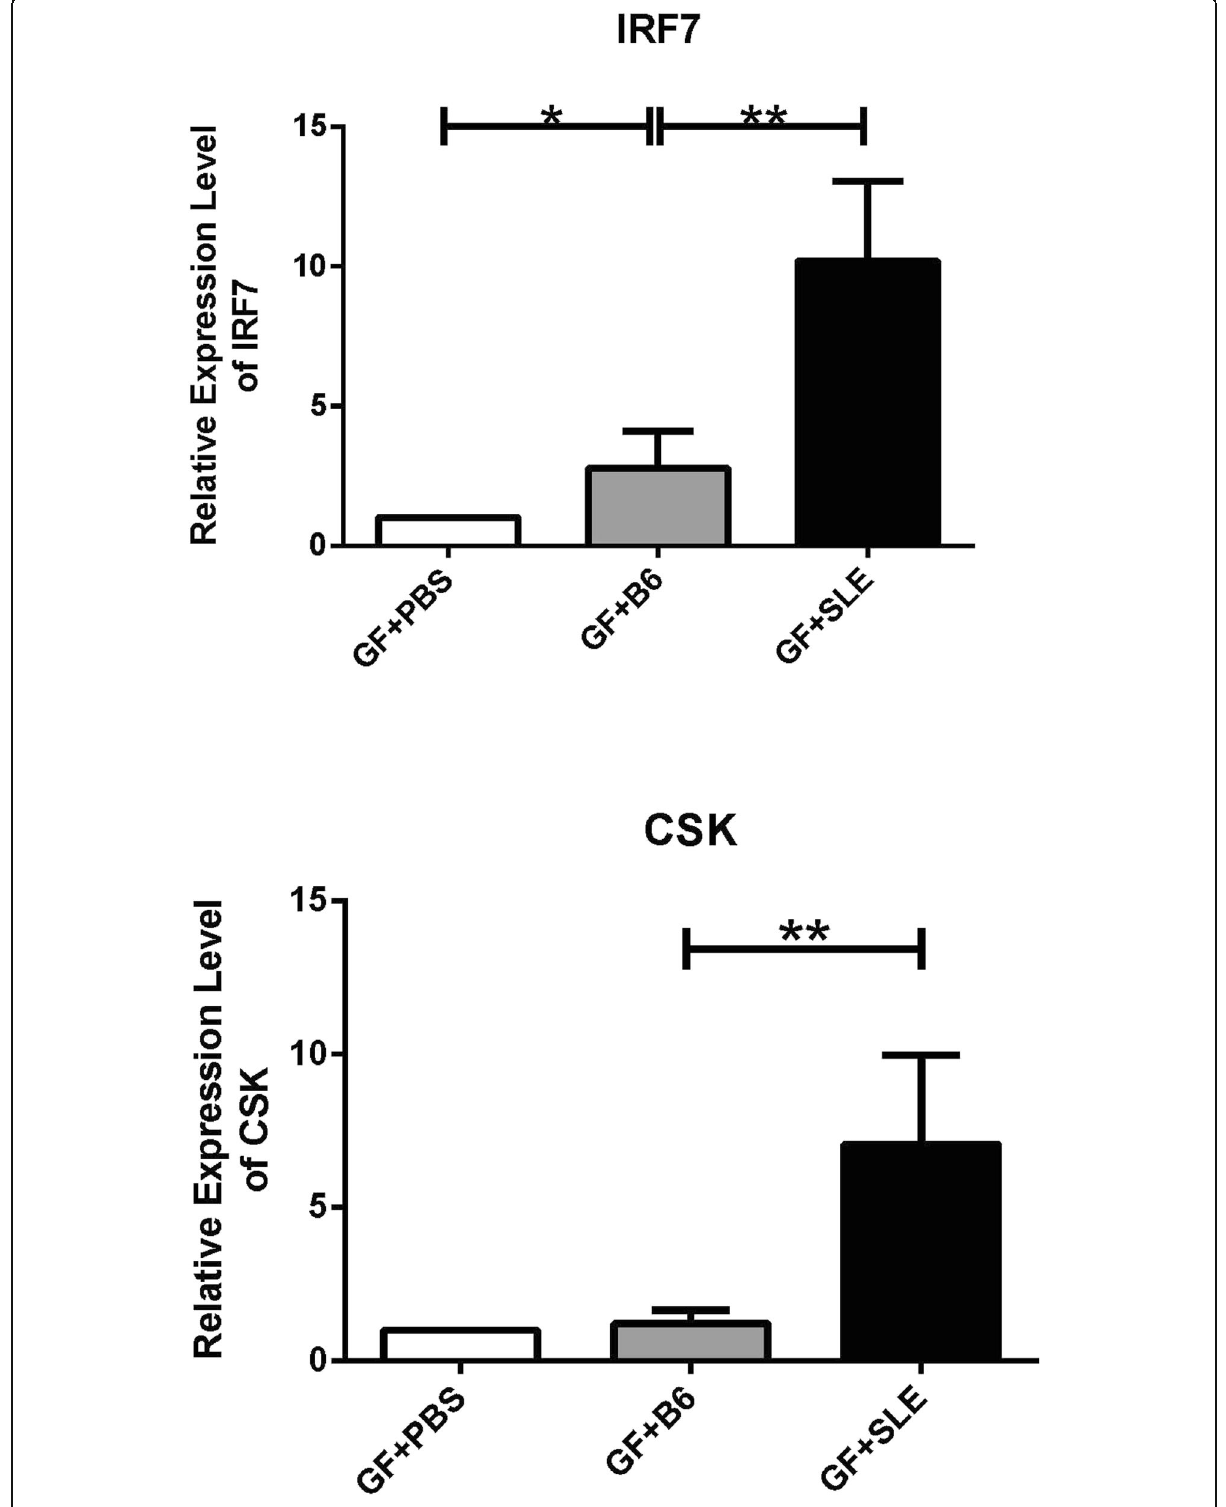
Fig. 6 Expression of two major SLE susceptibility genes in GF + PBS mice, GF + B6 mice, and GF + SLE mice. (A) IRF7 (4 mice per group). (B) CSK (4 mice per group). A Mann-Whitney t -test was used to compare the two groups. Error bars represent means ± SEMs. * P < 0.05, ** P <